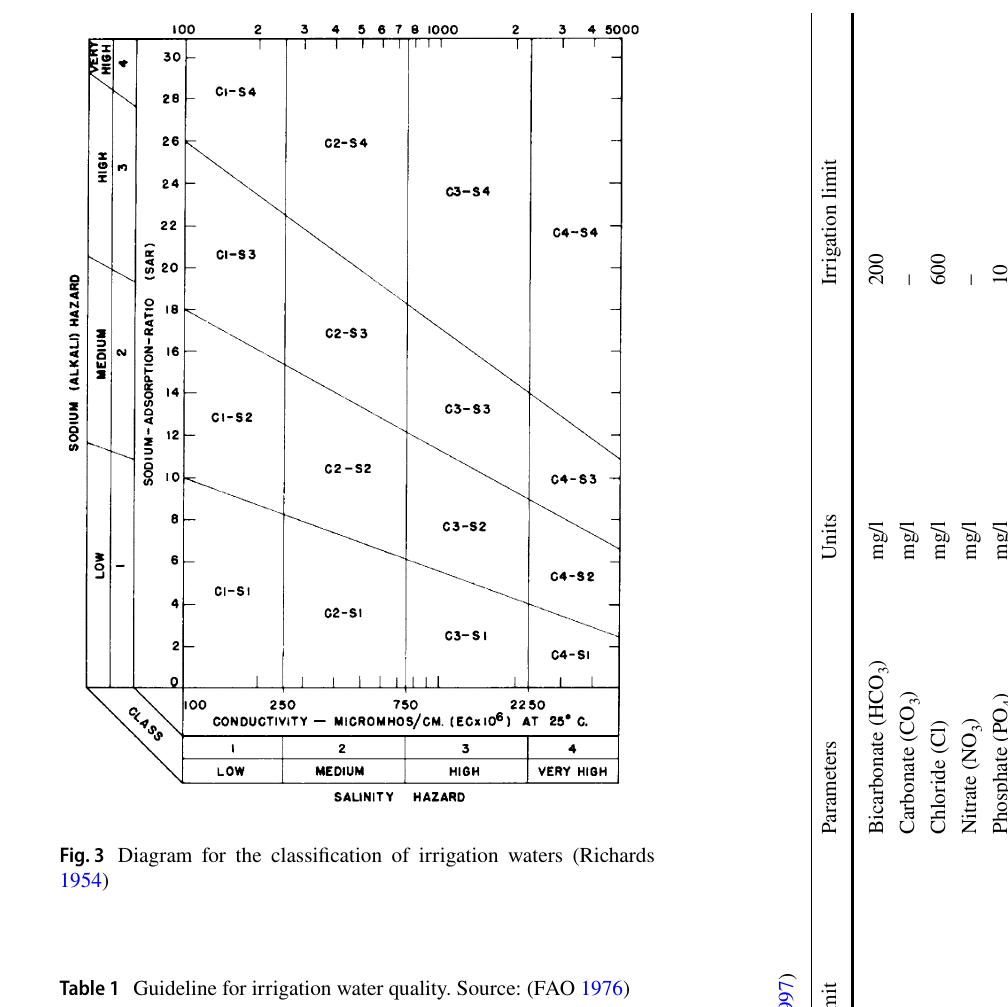
Table 1 Guideline for irrigation water quality. Source: (FAO 1976)